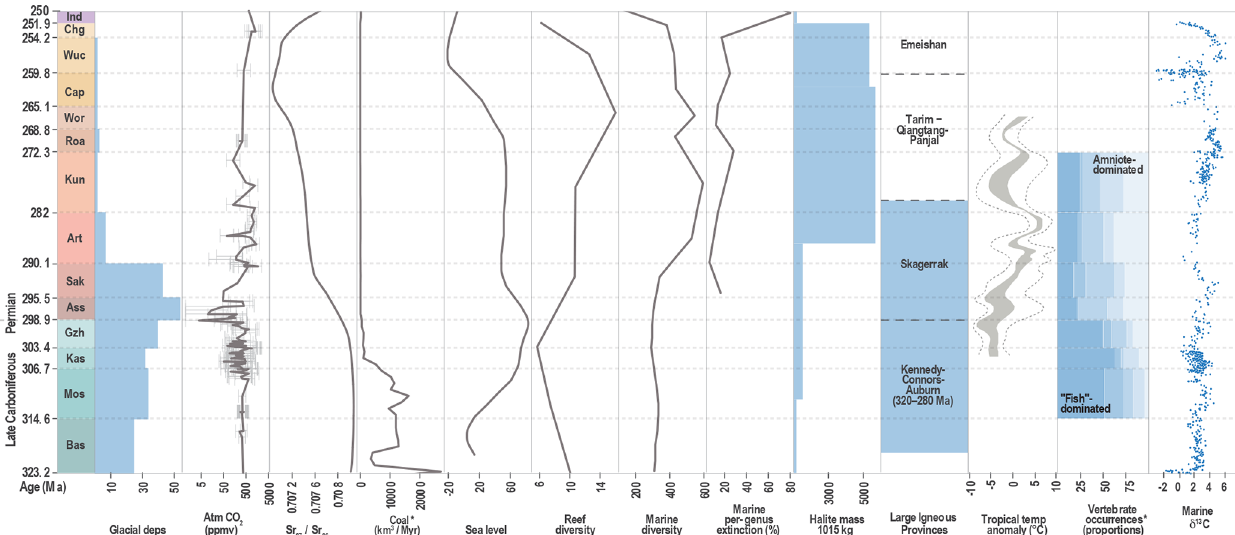
Figure 2. Illustration of documented glacial deposits (Soreghan et al., 2019), atmospheric p CO 2 (Montañez et al., 2016; Foster et al., 2017), strontium isotope signature (McArthur et al., 2001), terrestrial and North American terrestrial organic sediment (coal, lignite, anthracite, and tar) accumulation ∗ (Nelsen et al., 2016), sea-level changes (Haq and Schutter, 2008), mean species richness of reef builders in 10Myr bins (Kiessling, 2005; Alroy et al., 2008; Payne and Clapham, 2012), halite mass (Hay et al., 2006; Warren, 2016), and large igneous provinces (LIP Commission) during the late Carboniferous (Pennsylvanian) and Permian (323–251Ma), proportion of vertebrate (fish versus amniote- dominant) species in the North American continental realm (Pardo et al., 2019), a tropical temperature curve adapted from Montañez et al. (2007), and marine C 13 adapted from Saltzmann and Thomas (2012). ∗ indicates North America only, otherwise global signatures. Table 1. European target decision matrix. Paris Basin Switzerland Poland Bay